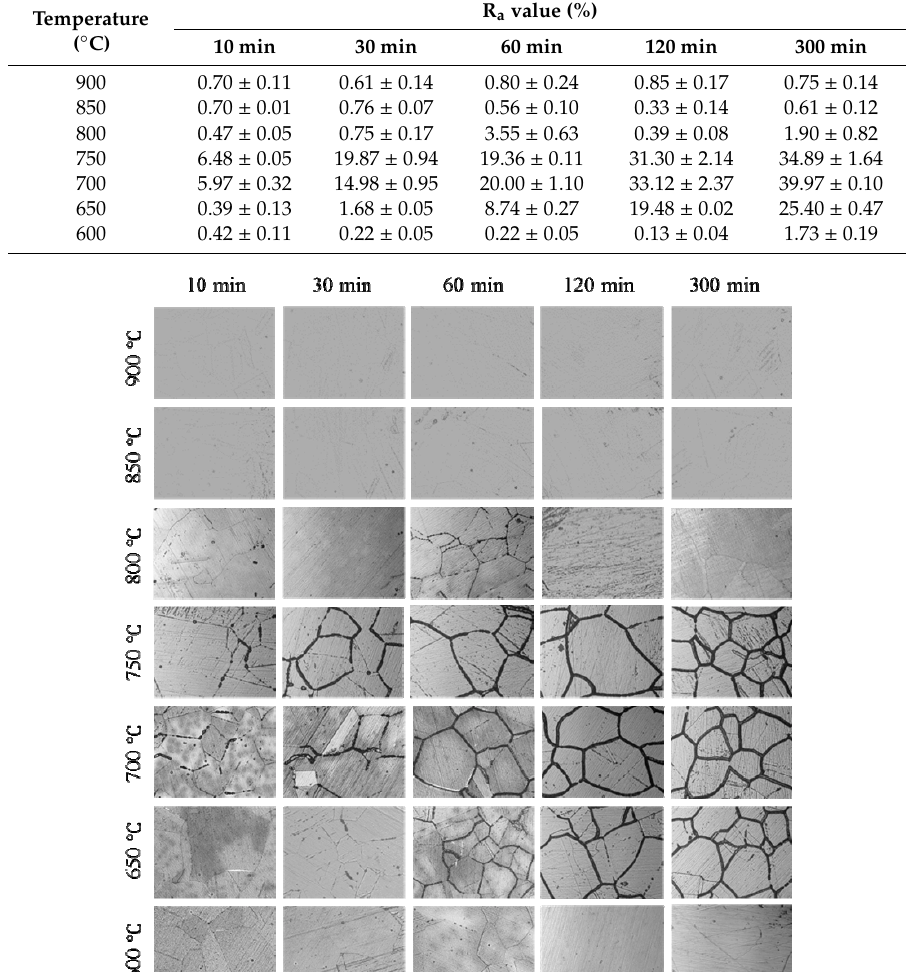
Figure 4. Optical micrographs of the Cr–Mn–Ni–N–Cu austenitic stainless steel samples aged under different heat treatment conditions after the DL-EPR test.